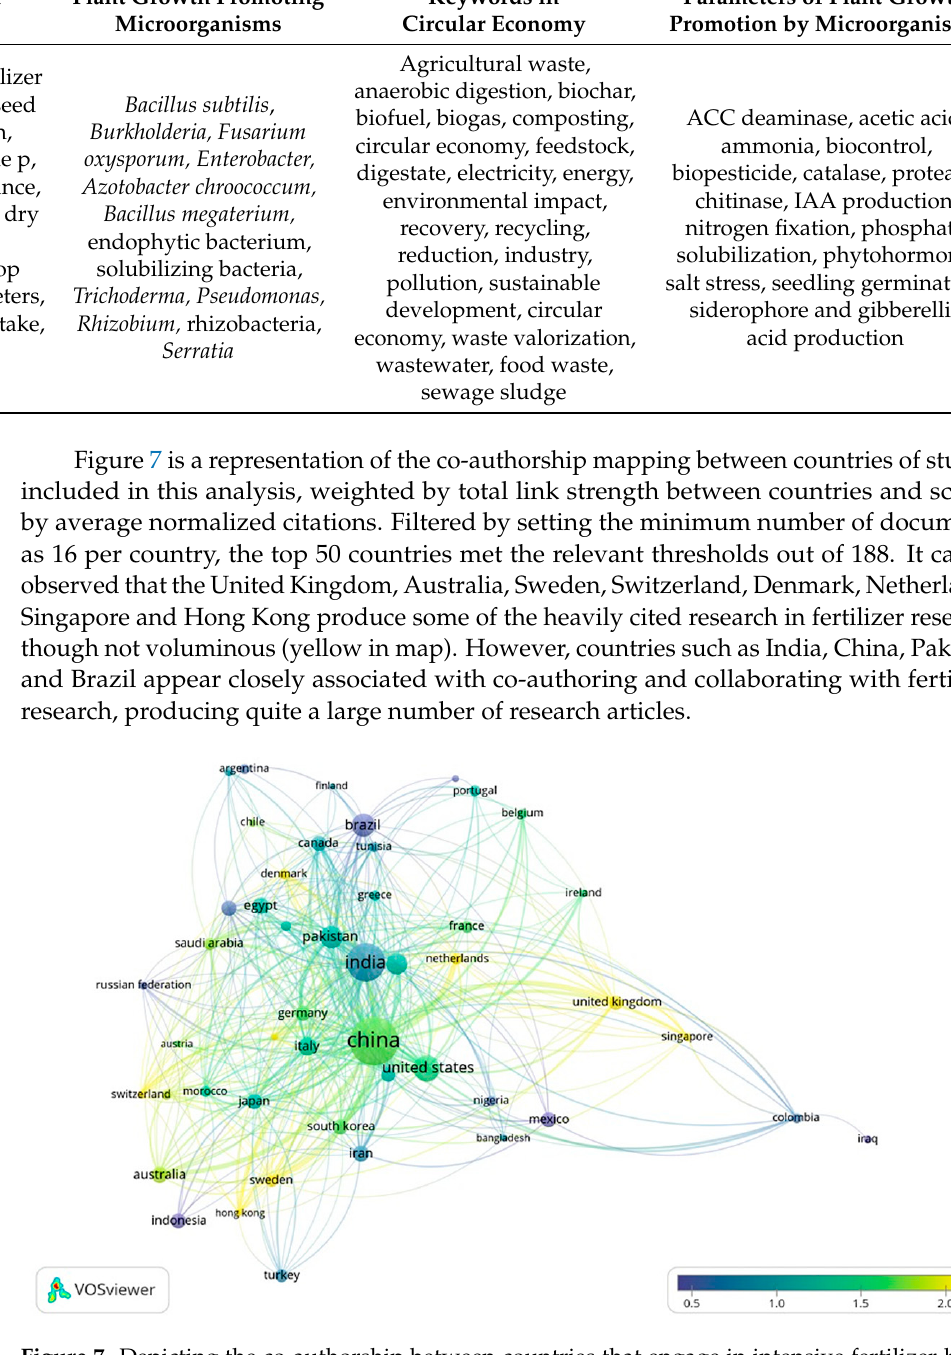
Figure 7. Depicting the co-authorship between countries that engage in intensive fertilizer-based research and their citation weightage.